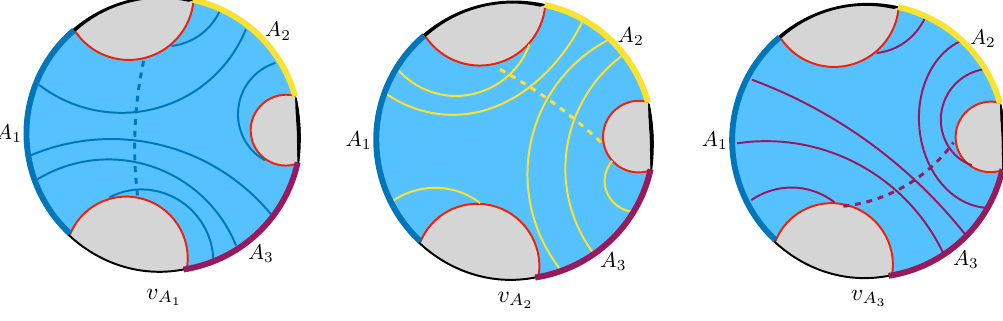
Figure 3 . An example of a maximal flow configuration V to (2.2) for three regions. Note the local flux on O , which we call α , is the same for all three of the flows. In the example each surface b p ( A i ) can support three threads while each surface Σ( A i ) can support